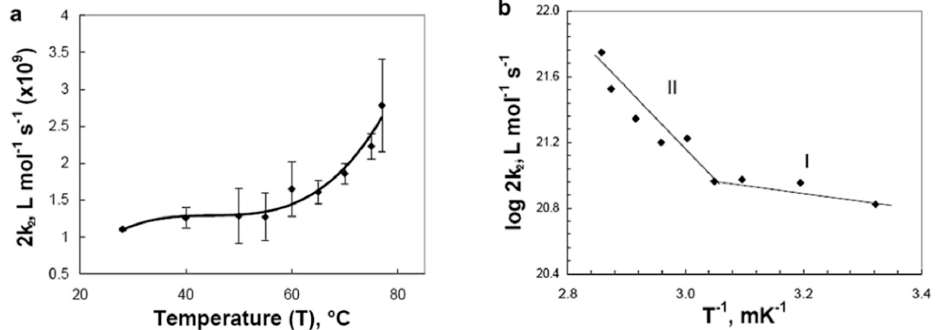
Figure 27. ( a ) Second-order reaction decay rate constant (2k 2 ) as a function of temperature; ( b ) Arrhenius plot of 2k 2 showing how the average activation energies were derived from two di ff erent temperature regions (I and II) in N 2 O-saturated PVP aqueous solutions [289].